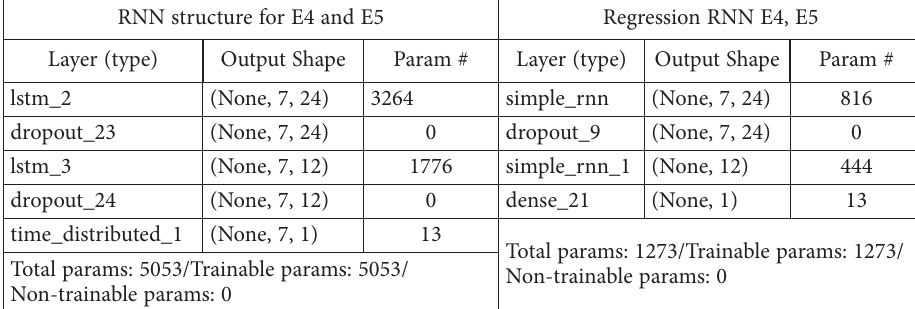
Table 7. The structure of the networks in E4 and E5 (source: authors’ calculation)